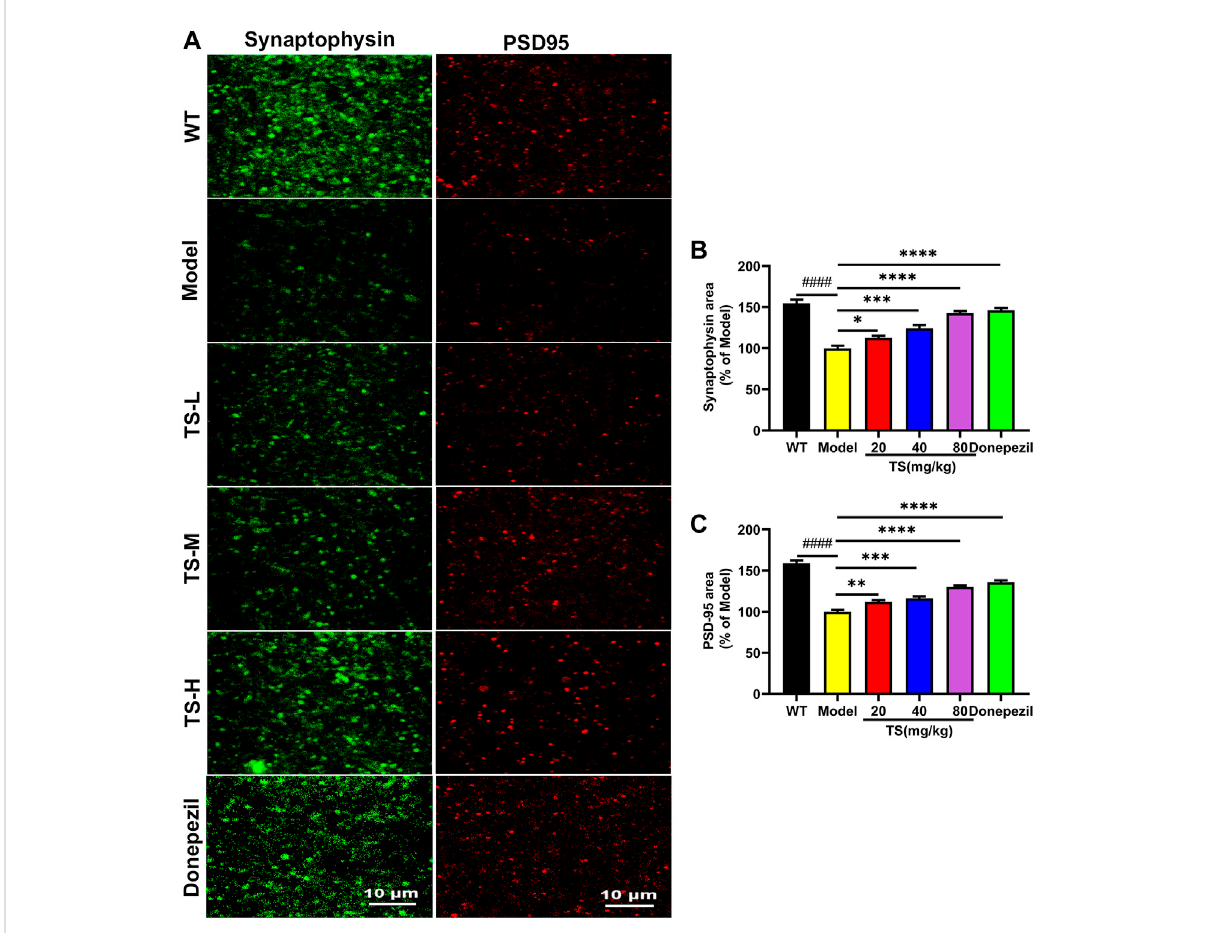
FIGURE 10 TStreatmentimprovedsynapticdysfunctioninAPP/PS1mice. (A) TheeffectofTSonthelevelofsynaptophysinandPSD-95inthebrainofAPP/ PS1 mice was investigated by immuno fl uorescence assay. (B) Quantitative analysis of the percentage of synaptophysin positive area in the brain of APP/PS1 mice ( #### p < 0.0001, * p = 0.0496, **** p < 0.0001). (C) Quantitative analysis of the percentage of PSD-95 positive area in the brain of APP/ PS1 mice ( #### p < 0.0001, ** p = 0.0059, *** p = 0.0002, **** p < 0.0001). # Compared with WT group; *Compared with model group. Data are presented as mean ± SEM ( n =